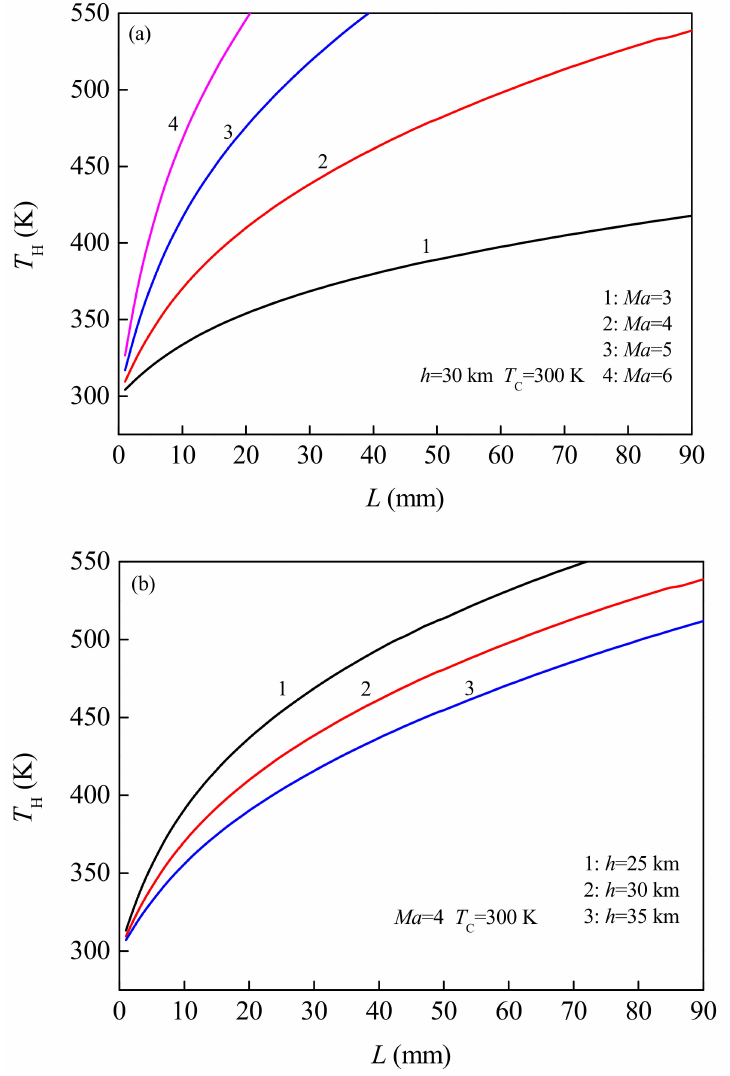
Figure 5. Variation of hot end temperature of TEG changing with the length of the TE leg under different flight Mach numbers ( a ) and flight altitudes ( b